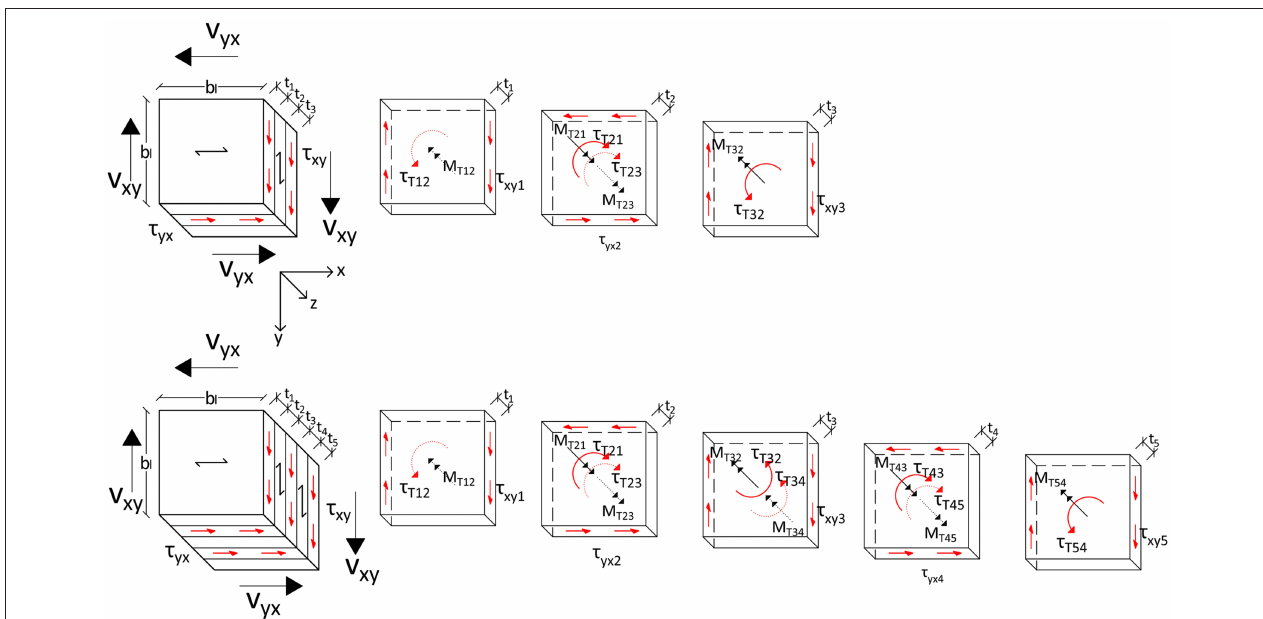
FIGURE 4 | Shear stresses for the equilibrium